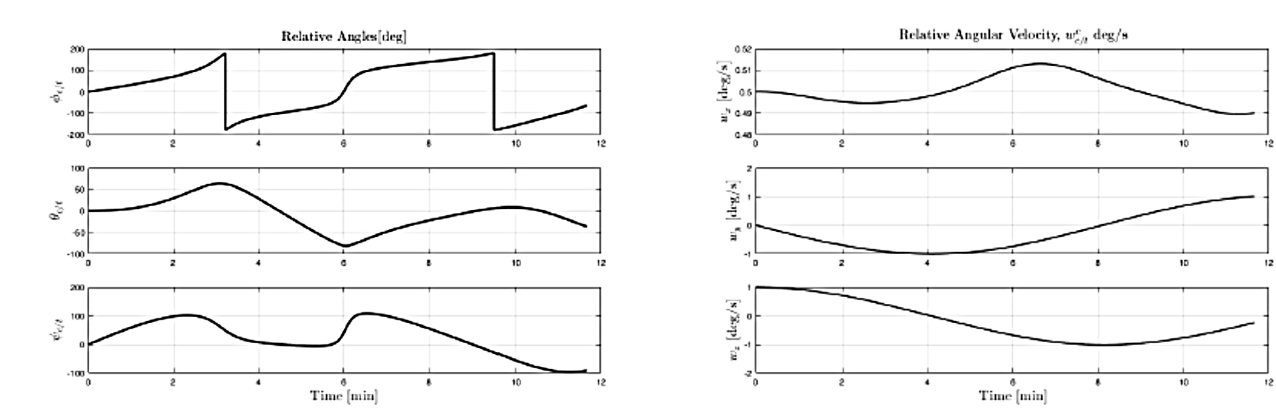
Figure A1. Attitude and attitude rate no PID.